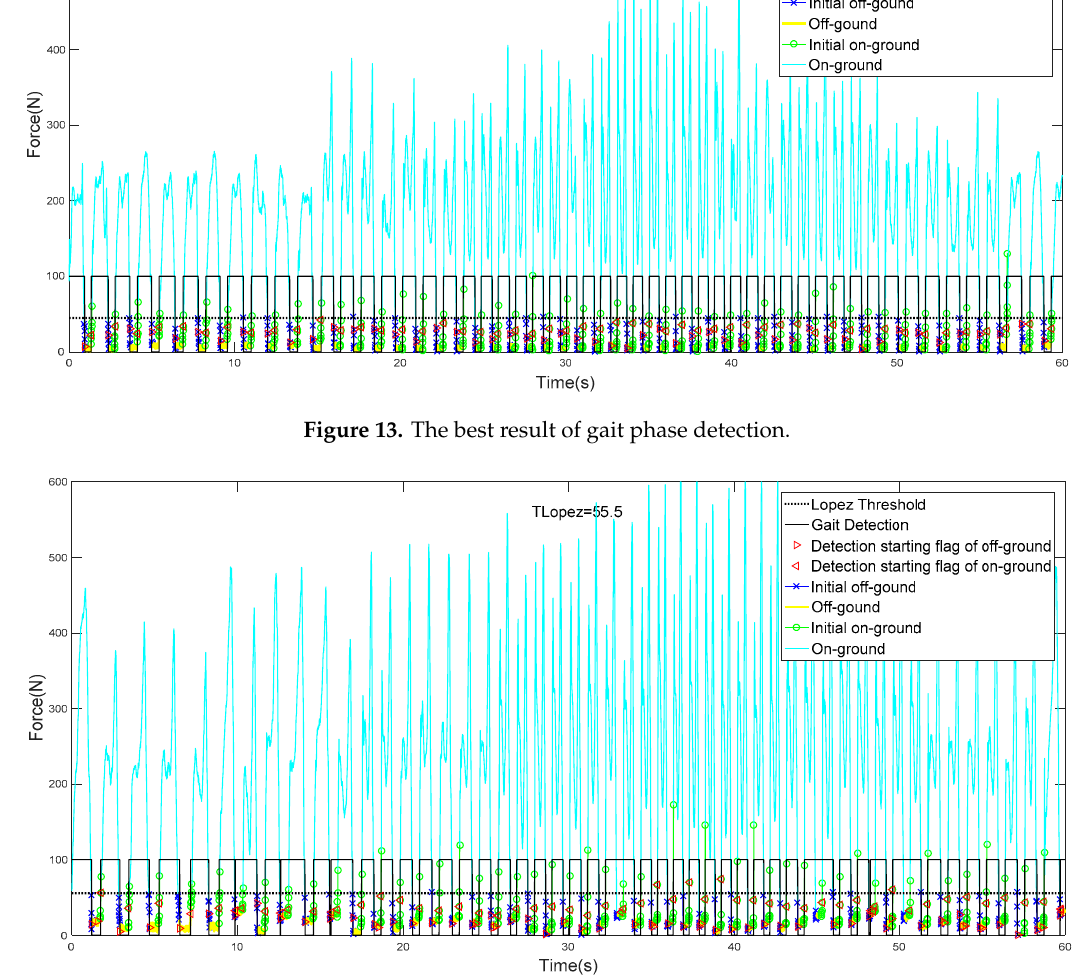
Figure 14. The worst result of gait phase detection.